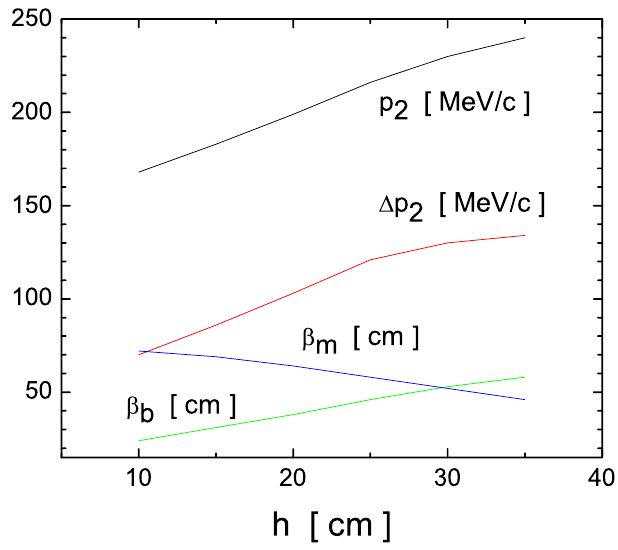
FIG. 16. (Color) Location of the center of the second passband p , the width of the band, the beta function at the cell boundary 2 (cid:4) , and the beta function at the cell midplane (cid:4) as a function of b m the distance h . The other parameter values were d (cid:2) 2 : 5 m , L (cid:2) 18 cm , a (cid:2) 35 cm , t (cid:2) 17 cm , J (cid:2) 73 A = mm 2 , g (cid:2) 54 cm , (cid:2) 70 cm , t (cid:2) 12 cm , and J (cid:2) 75 A = mm 2 a c c c